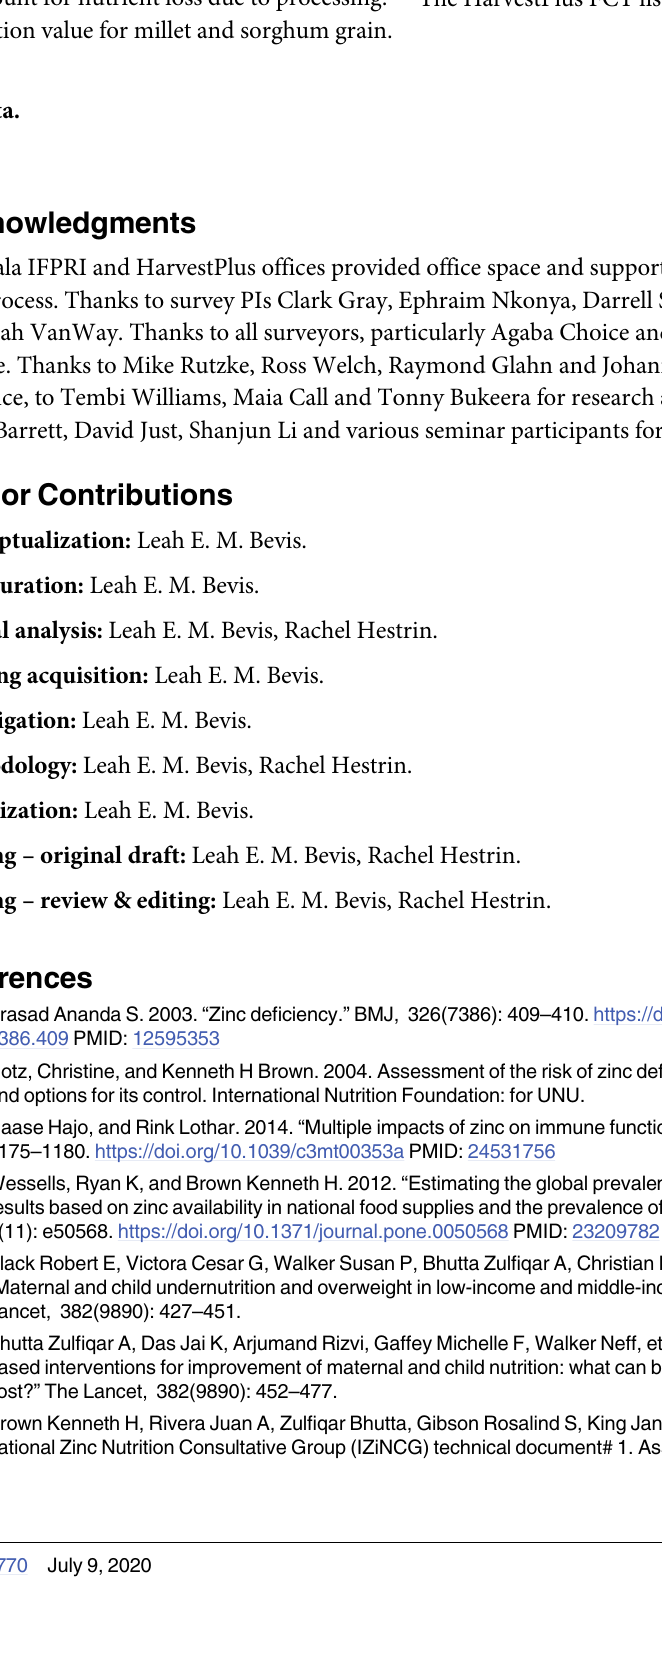
S1 Table. Food frequency questionnaire. S2 Table. Food and data sources used to estimate dietary zinc intake. � Indicates adjustment to account for nutrient loss due to processing. �� The HarvestPlus FCT lists the same Zn con- centration value for millet and sorghum